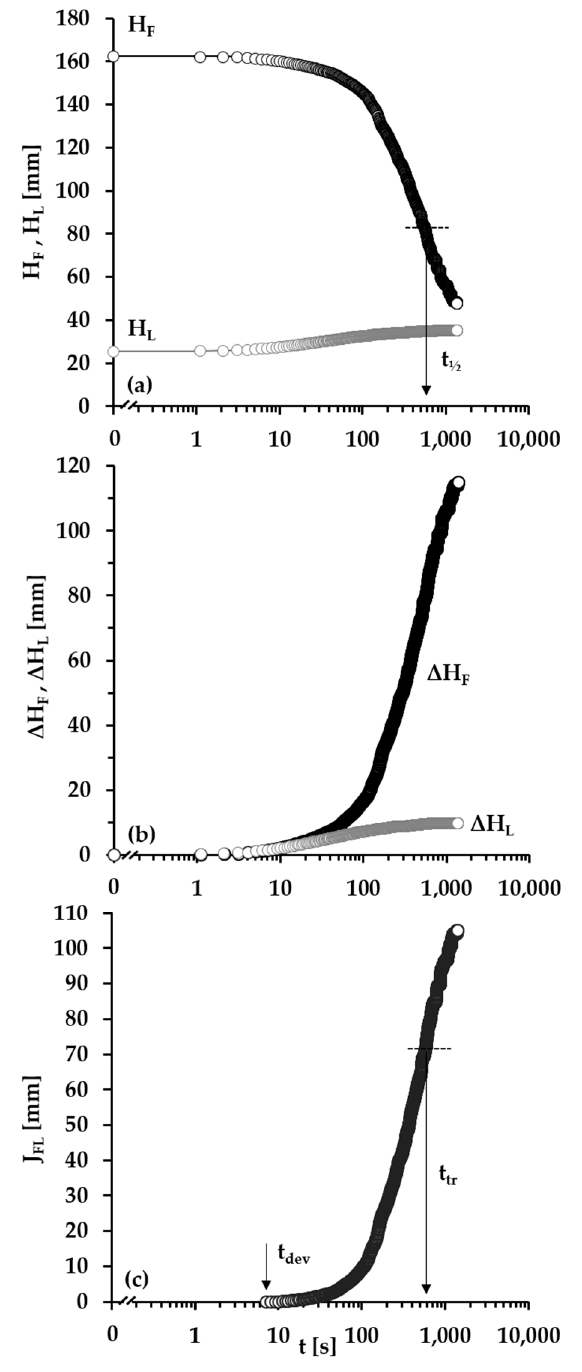
Figure 1. Foam obtained from a 100 µM β -lactoglobulin (BLG) solution at pH 3 and C buff = 10 mM. ( a ) H F (t) and H L (t) kinetic curves; ( b ) Δ H F (t) and Δ H L (t), and ( c ) J FL (t) dependencies. For definitions of these quantities and of the characteristic parameters t dev and t tr see Equations (1)–(5). Lines are guides to the eye; arrows indicate characteristic times.